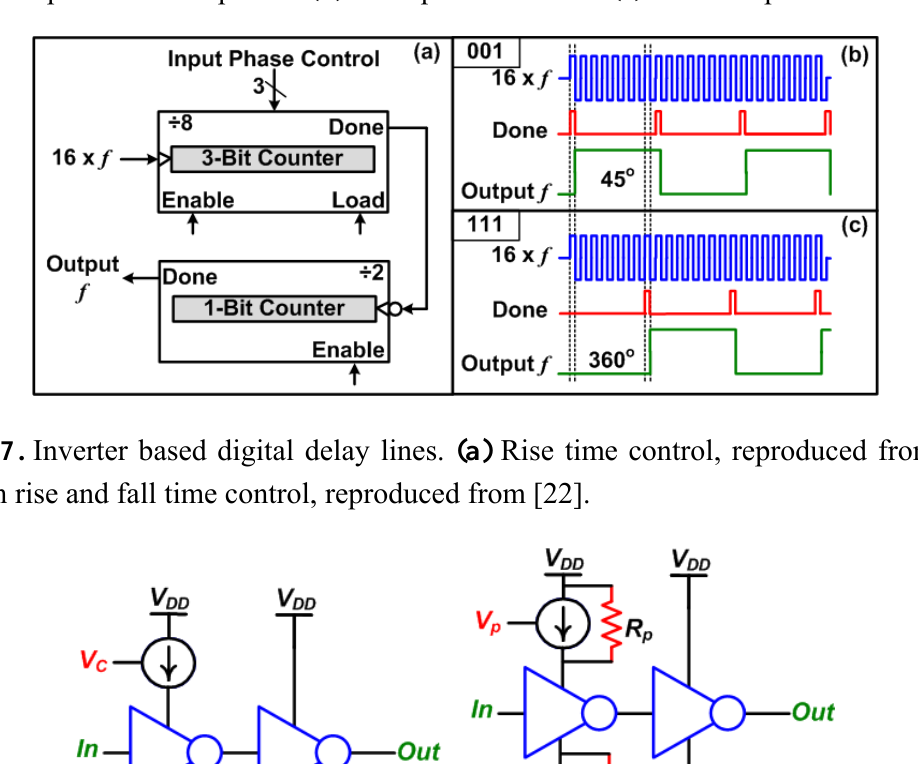
Figure 6. Digital phase shifter using programmable counters. (a) Schematic diagram, and functional operation examples of (b) a 45° phase shift and (c) and 360° phase shift.